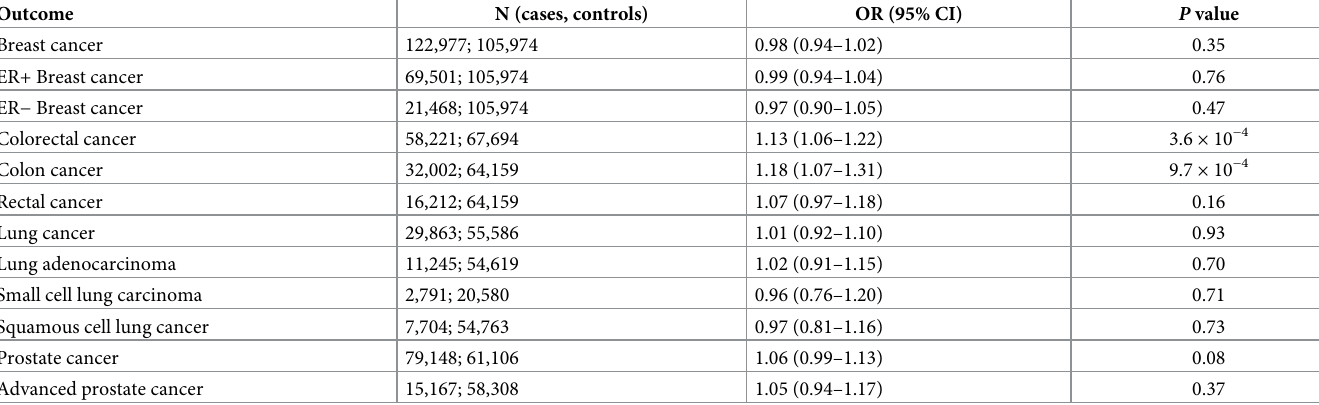
Table 2. Association between genetically proxied ACE inhibition and risk of overall and subtype-specific breast, colorectal, prostate, and lung cancer risk. Outcome N (cases, controls) OR (95% CI) P value Breast